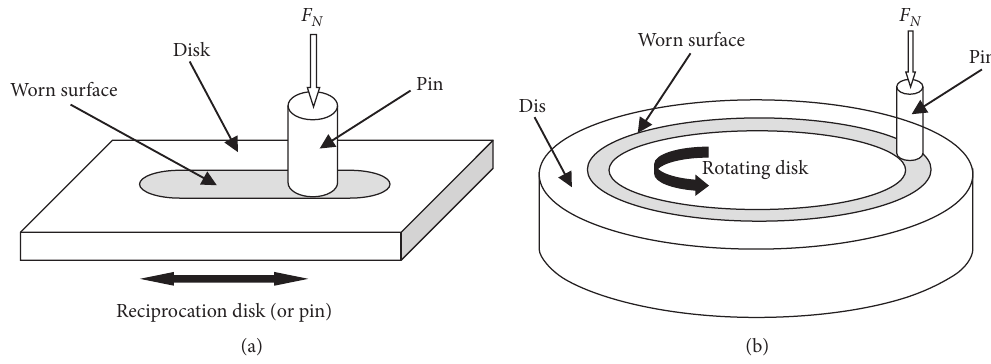
Figure 3: Illustration of the principle behind the pin-on-disk wear